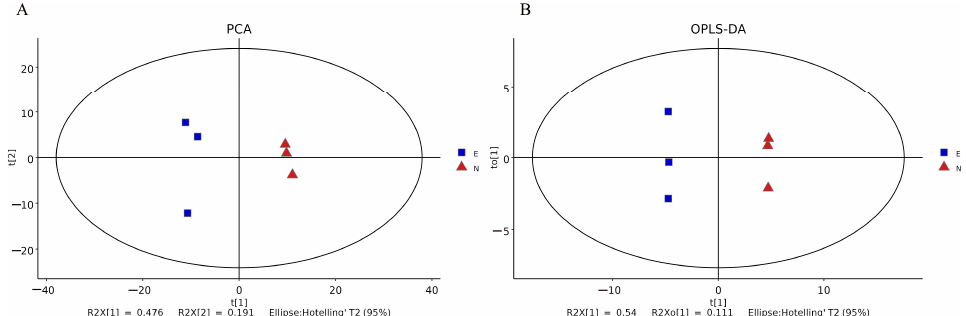
Figure 4. Data analysis of the metabolites based on GC/MS in the damaged leaves (E) of E. onukii and healthy leaves (N). ( A ) Principal component analysis (PCA). ( B ) Orthogonal projections to latent structures discriminant analysis (OPLS-DA).